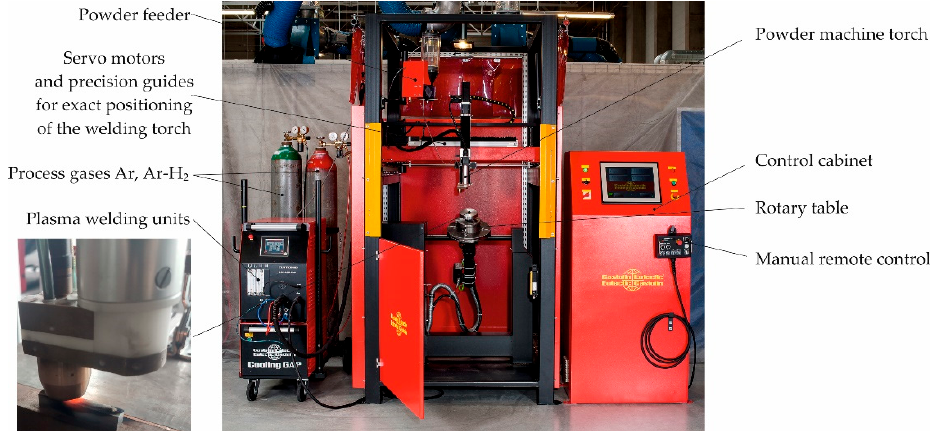
Figure 3. Gap automated unit robotic coating system. Table 4. Chemical composition of low-alloy structural steel AISI 4715 according to the manufac- turer’s data (TimkenSteel Ltd., Canton, OH, USA). Chemical Composition, wt.%